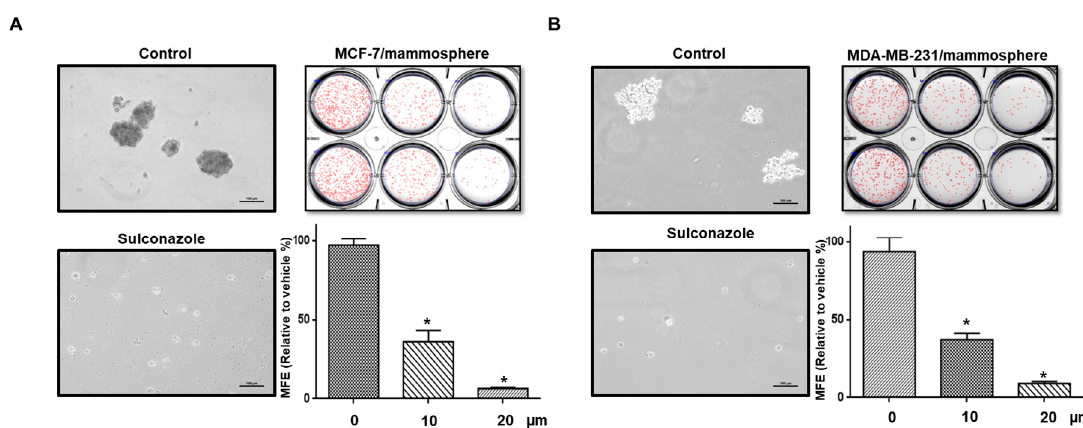
Figure 3. Effect of sulconazole on the mammosphere-forming ability of breast cancer cells. ( A , B ) Effect of sulconazole on the mammosphere formation of breast cancer cells. To establish mammospheres, MCF-7 and MDA-MB-231 cells were seeded at a density of 4 × 10 4 and 1 × 10 4 cells/well, respectively, in ultralow attachment 6-well plates containing 2 ml of complete MammoCult TM medium (StemCell Technologies) which was supplemented with 4 μ g/mL heparin, 0.48 μ g/mL hydrocortisone, 100 U/mL penicillin, and 100 μ g/mL streptomycin. Mammospheres were cultured with sulconazole (10 or 20 μ M) solubilized in 0.05% DMSO or 0. 1% DMSO. The breast cancer cells were incubated with sulconazole in CSC culture medium for 7 days. A mammosphere formation assay evaluated mammosphere formation efficiency (MFE, % of control), which corresponds to the number of mammospheres per well/the number of total cells plated per well ×100 as previously described (scale bar = 100 μ m) [22]. The data are presented as the mean ± SD; n = 3 independent experiments;* p < 0.05 vs. the control (0. 1% DMSO).